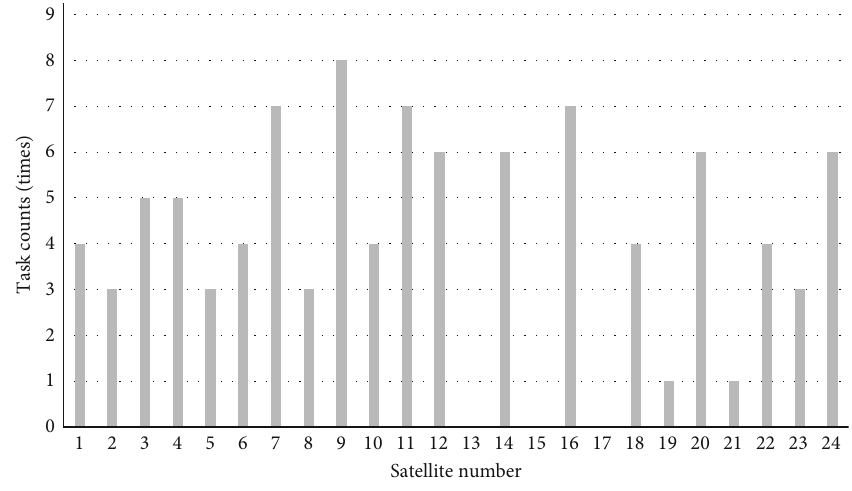
Figure 14: The result of the imaging task allocation of each